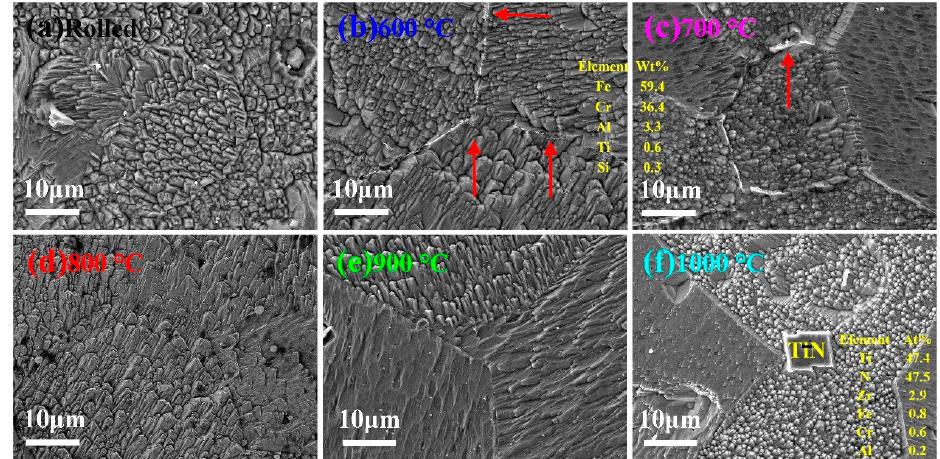
Figure 5. Typical SEM images (High magnification) showing α phase morphology and typical precipitates in the rolled and heat-treated Fe-25Cr-5Al-RE wire rod. ( a ): rolled; ( b ): 600 °C; ( c ): 700 °C; ( d ): 800 °C; ( e ): 900 °C; ( f ): 1000 °C.